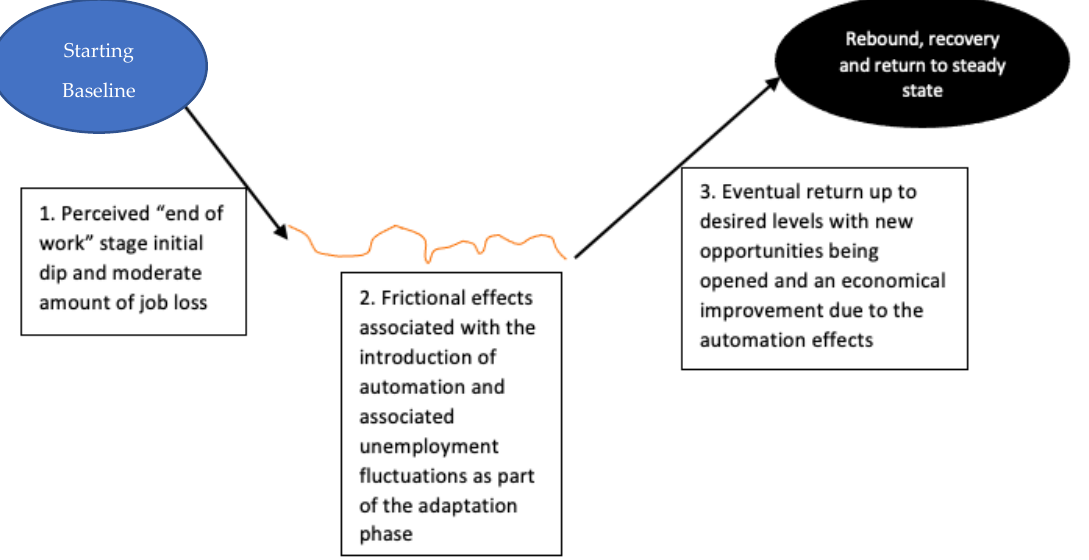
Figure 13. Diagram showing the various phases associated with the introduction and adaptation of automation technology.